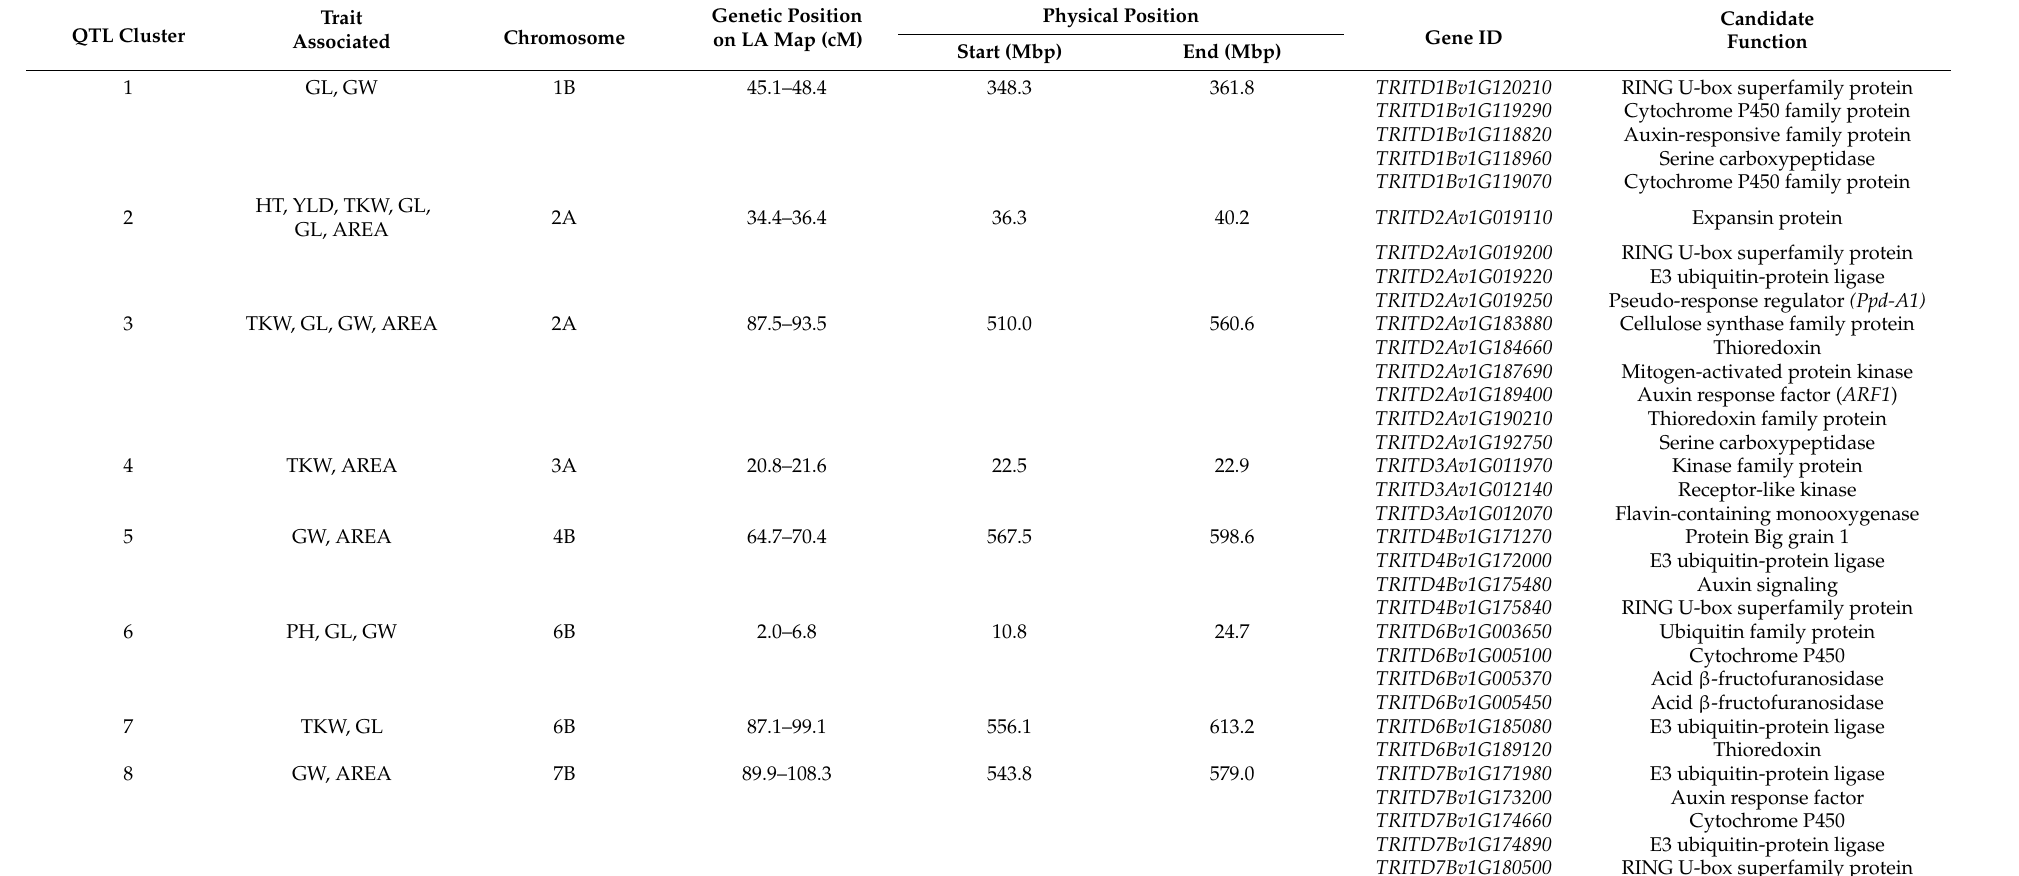
Table 6. Physical position and candidate genes within the QTL cluster detected on Liberdur x Anco Marzio genetic map evaluated for grain yield (YLD), plant height (PH), heading time (HT), thousand kernel weight (TKW), grain length (GL), grain width (GW), grain area